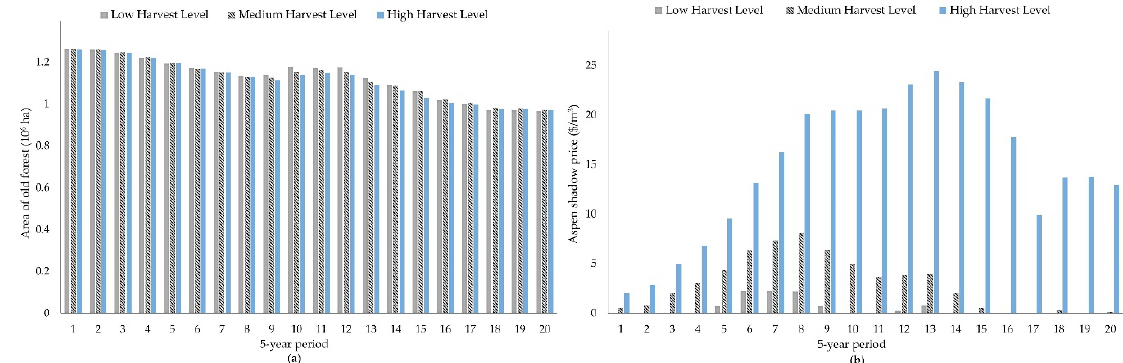
Figure 5. Amount of old forest produced under three aspen harvest levels and the high marginal value function for old forest (showed in Figure 2) ( a ) and aspen shadow prices for the three aspen harvest levels and the high marginal value function for old forest ( b ).